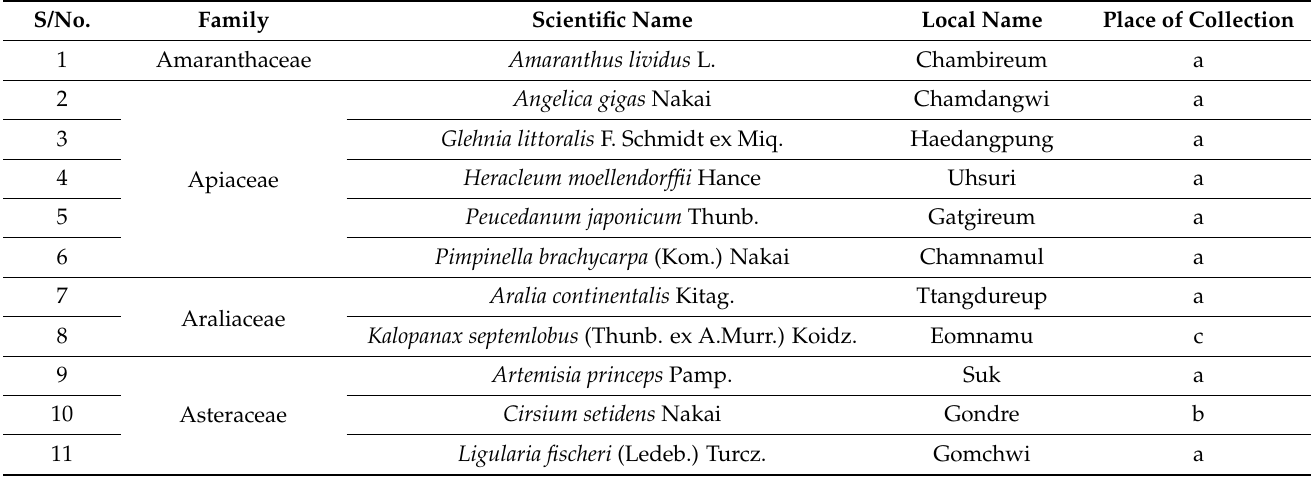
Table 1. List of different traditional green leafy vegetables (GLVs) investigated in the present study.